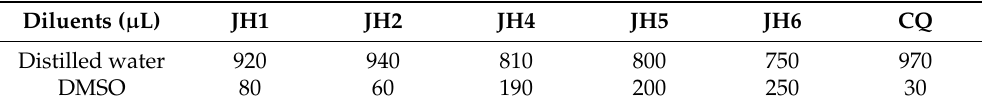
Table 2. Preparation of bis-THTT solutions.